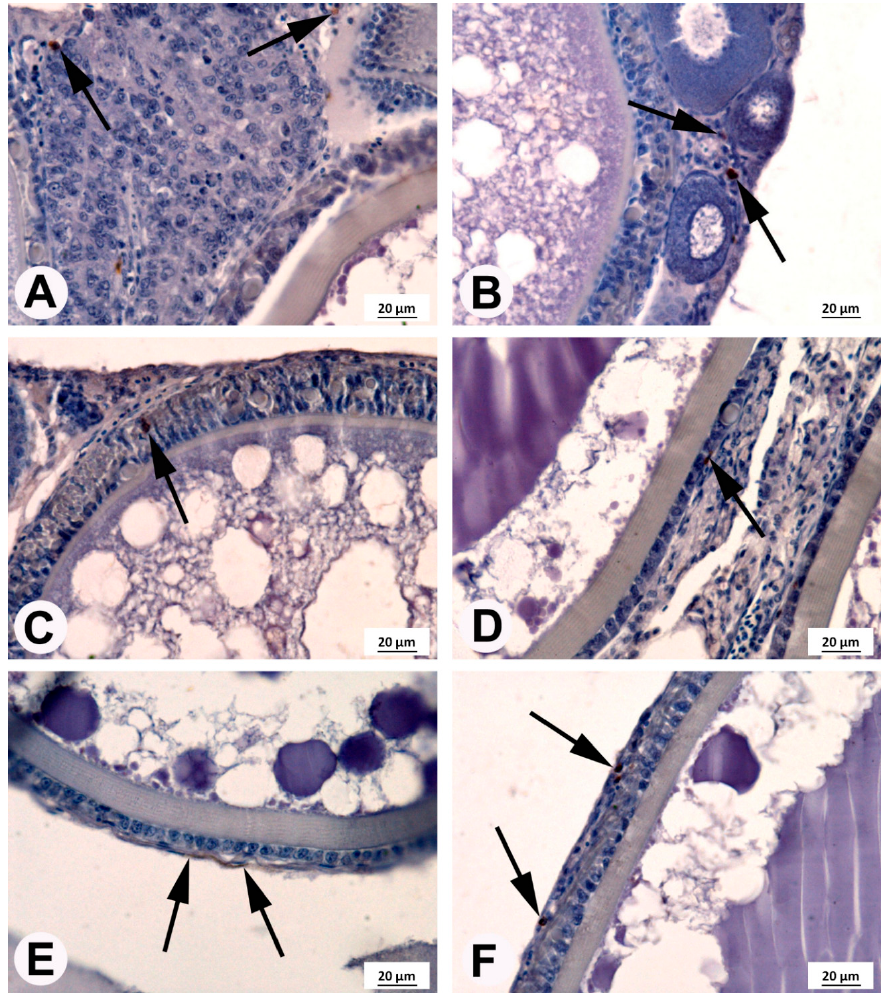
Figure 5. Localization of cyclooxygenase 2 (COX2)-positive cells (arrows) in the medaka ovaries. ( A ) Germinal epithelium; ( B ) growing follicles without the COX2-positive reaction and the COX2-positive cells were localized in germinal epithelium; ( C ) oocyte of medaka from control fish fed 4 mg ARA g − 1 of TFA at stage VII (vitellogenic phase) with COX2-positive cells present in the follicular layers; ( D ) oocyte of medaka from fish supplemented with 5 mg g − 1 of TFA at stage IX (postvitellogenic phase) with COX2-positive cells present in the follicular layers; ( E ) oocyte of medaka from fish supplemented with 14 mg g − 1 of TFA at stages VIII (vitellogenic phase) with COX2-positive reaction in theca cells; ( F ) oocyte of medaka from fish supplemented with 23 mg g − 1 of TFA at stage IX (postvitellogenic phase) with COX2-positive cells present in follicular